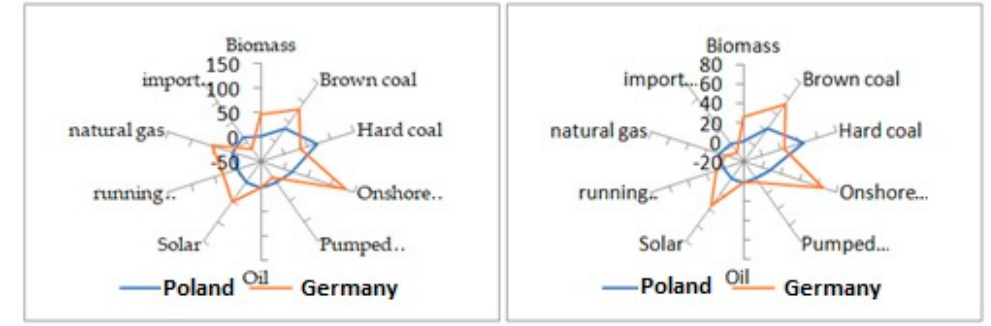
Figure 26. Comparison of Poland and Germany 2020 [73].